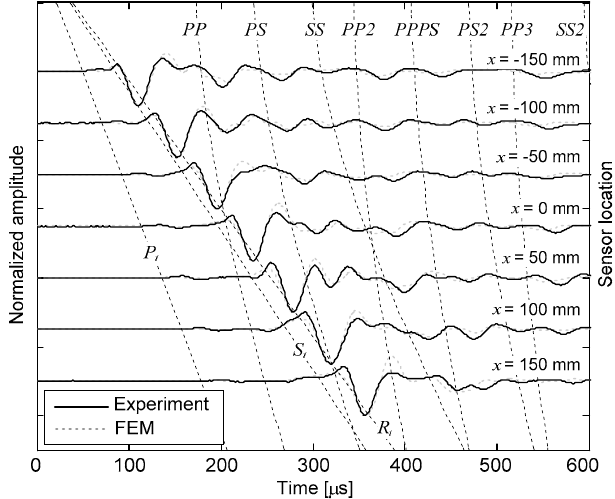
Figure A2. Comparison of time signals measured on the free surface of a Plexiglas specimen in the laboratory and those obtained from FE simulations.